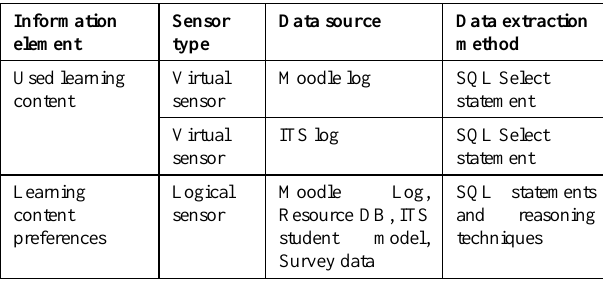
I NFORMATION E LEMENT AND D ATA S OURCE R